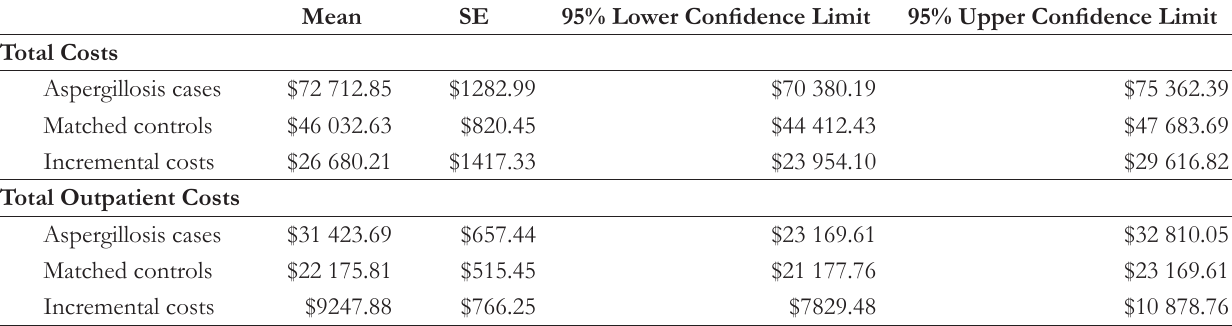
Table 6. Multivariate-adjusted * Total and Outpatient Costs of Patients with